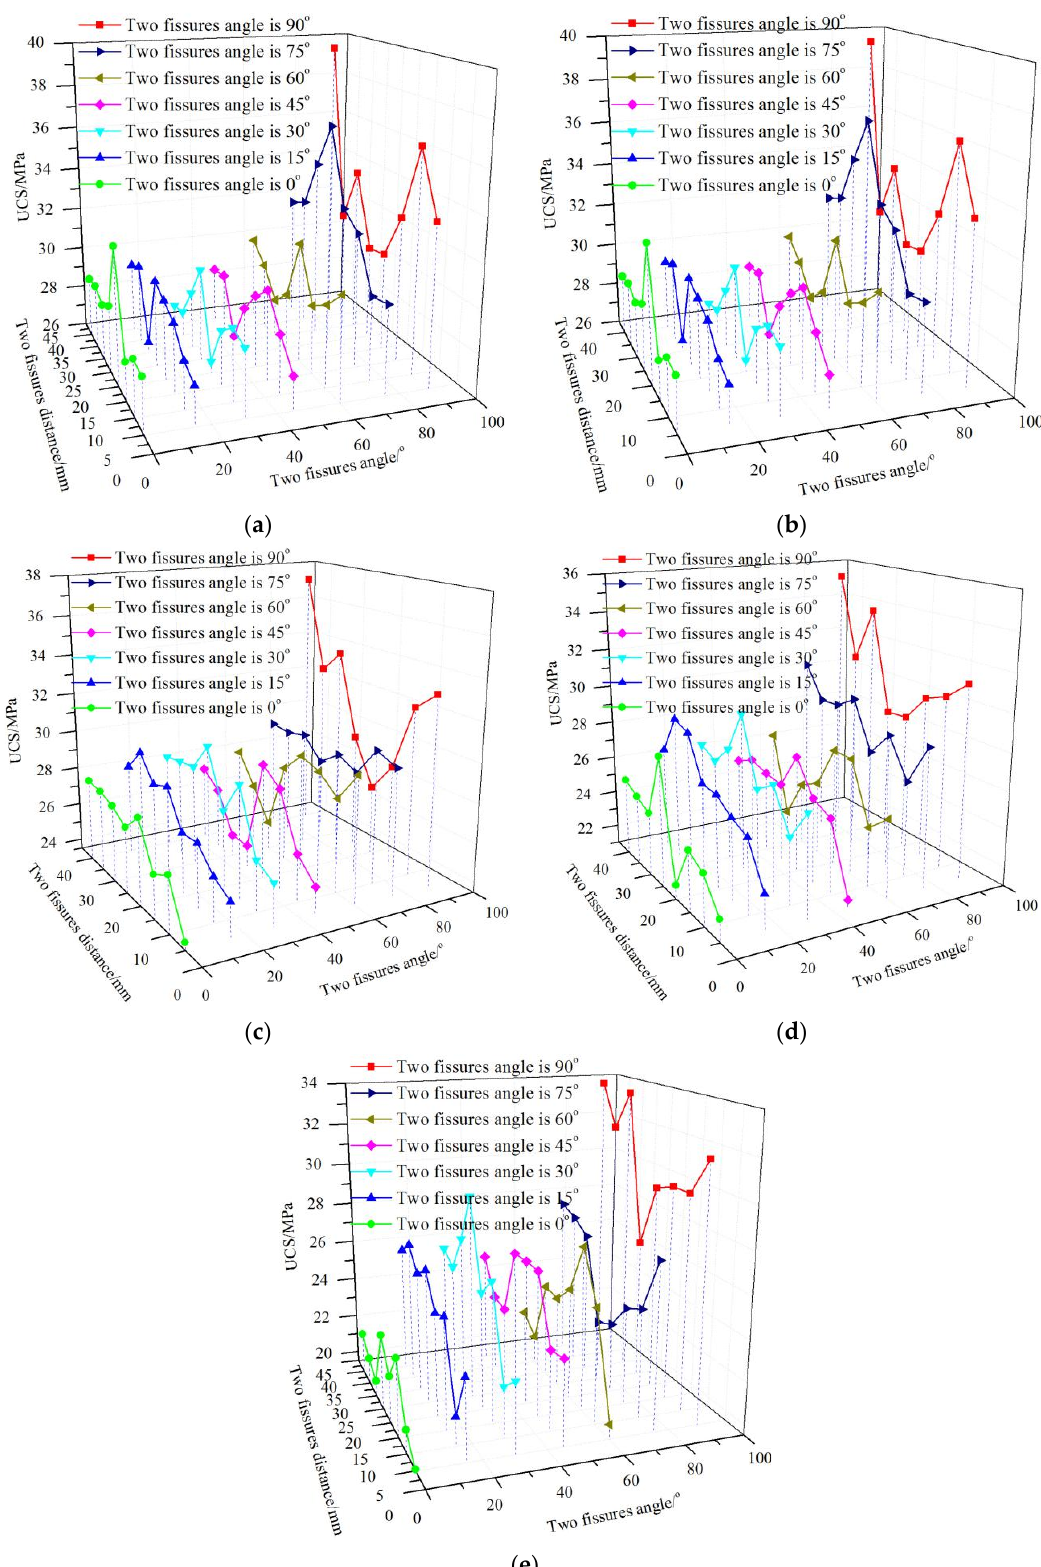
Figure 6. UCS of rock-like materials with variations in fissure distance. ( a ) 10 mm; ( b ) 20 mm; ( c ) 30 mm; ( d ) 40 mm; and ( e ) 50 mm.